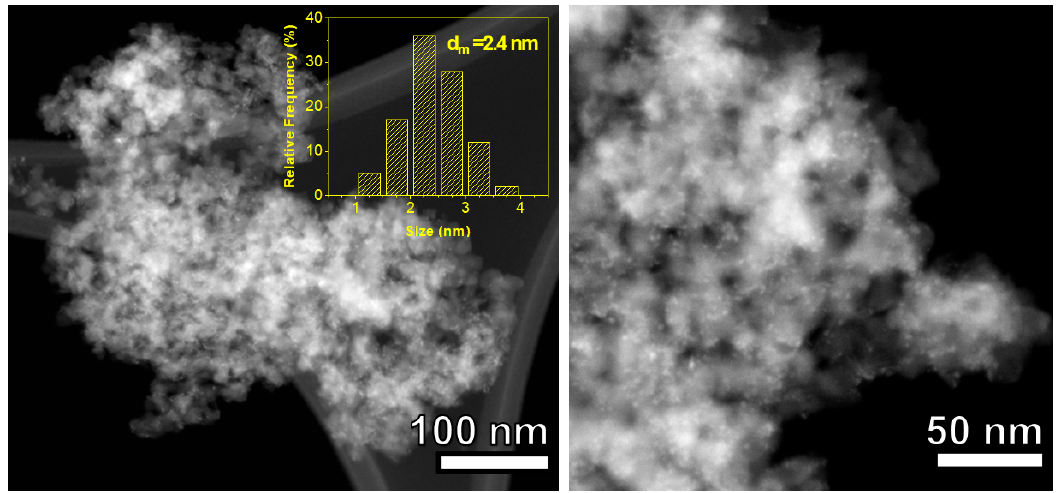
Figure 1. Representative STEM images of sample Cu/SiO 2 A and related particle size distribution (inset on the left side).